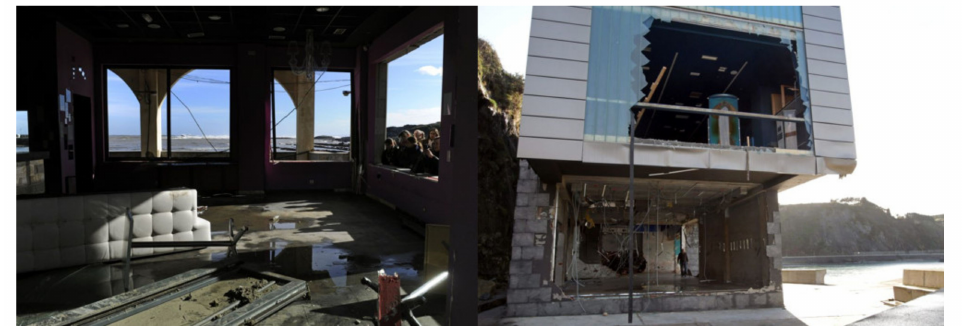
Figure 2. Buildings progressively damaged by extreme events. November 2010 storm (source: own